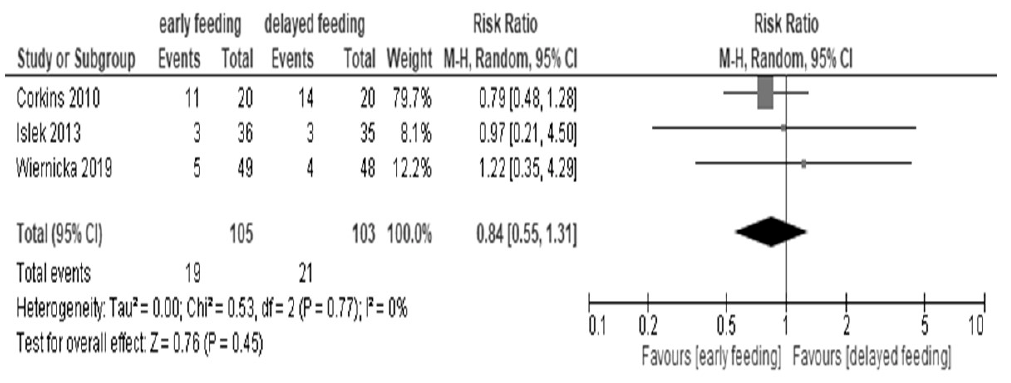
Figure 3. Forest plot of hospital stay (hours).